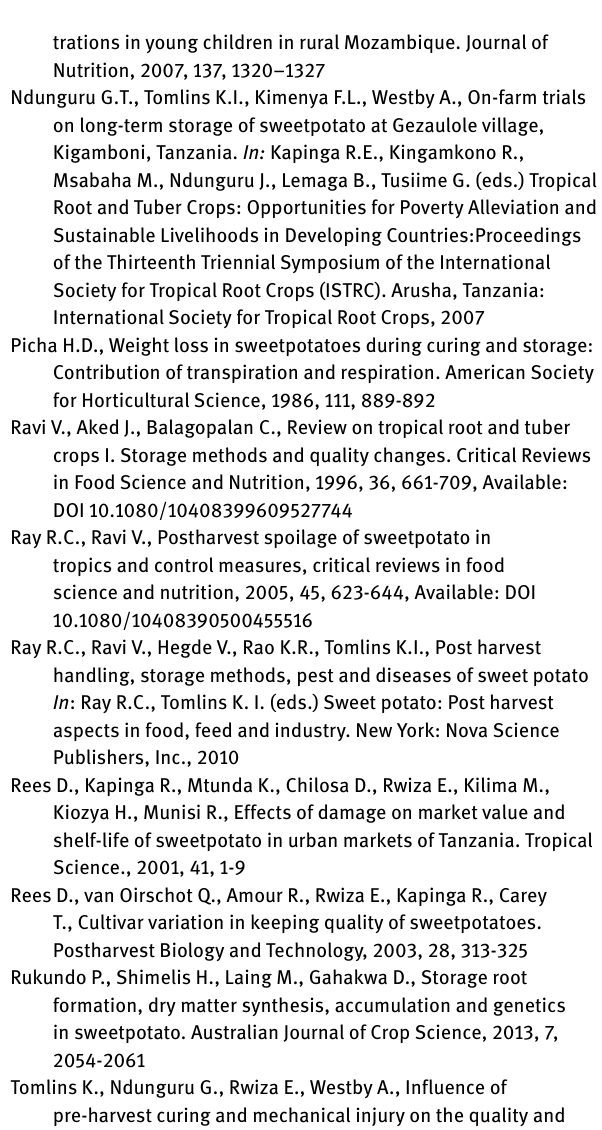
Figure 7: Dry matter as influenced by curing method after 7-day curing period. Bars value (least square means ± SEM, n = 3). Least square means with the same letters are not significantly different (p >